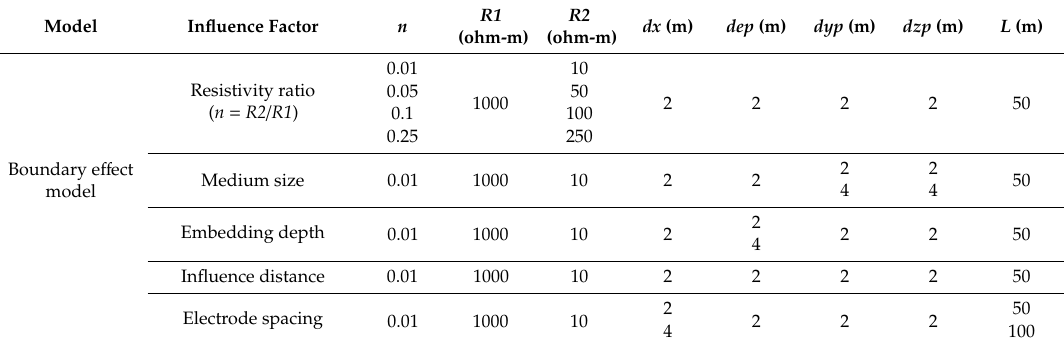
Table 2. The explanatory table of the boundary e ff ect stratum model parameters.